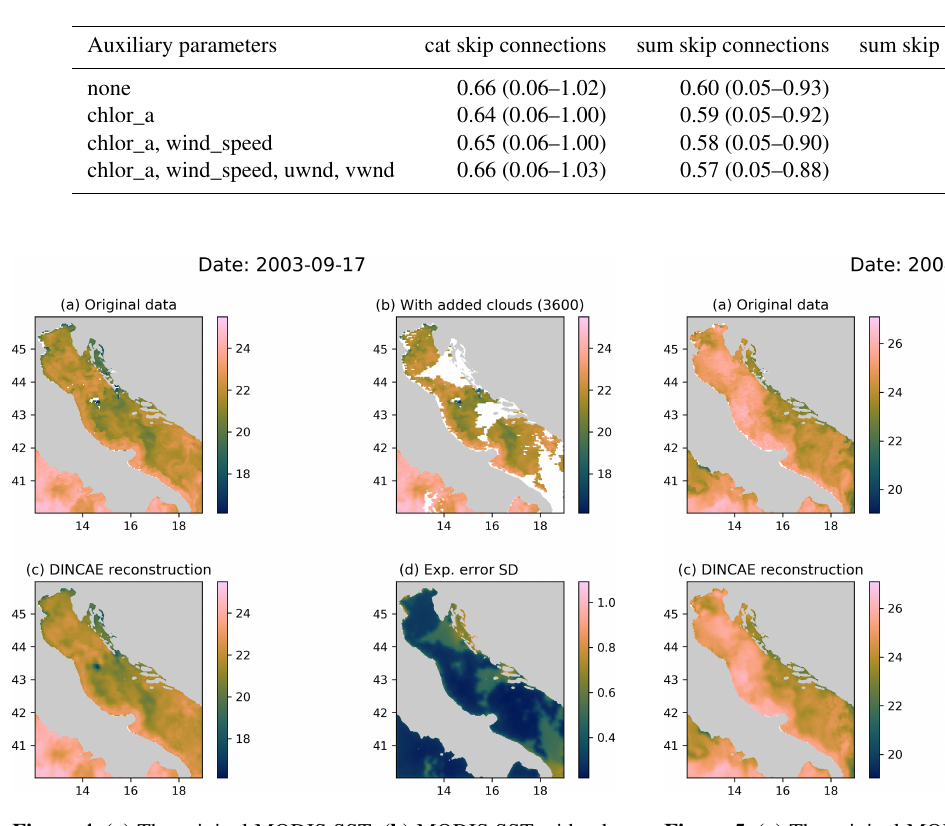
Figure 4. (a) The original MODIS SST; (b) MODIS SST with ad- ditional clouds for cross-validation; (c) the DINCAE reconstruction using the data from panel (b) ; (d) the expected error standard devi- ation of the DINCAE reconstruction. All panel values are in ◦ C.